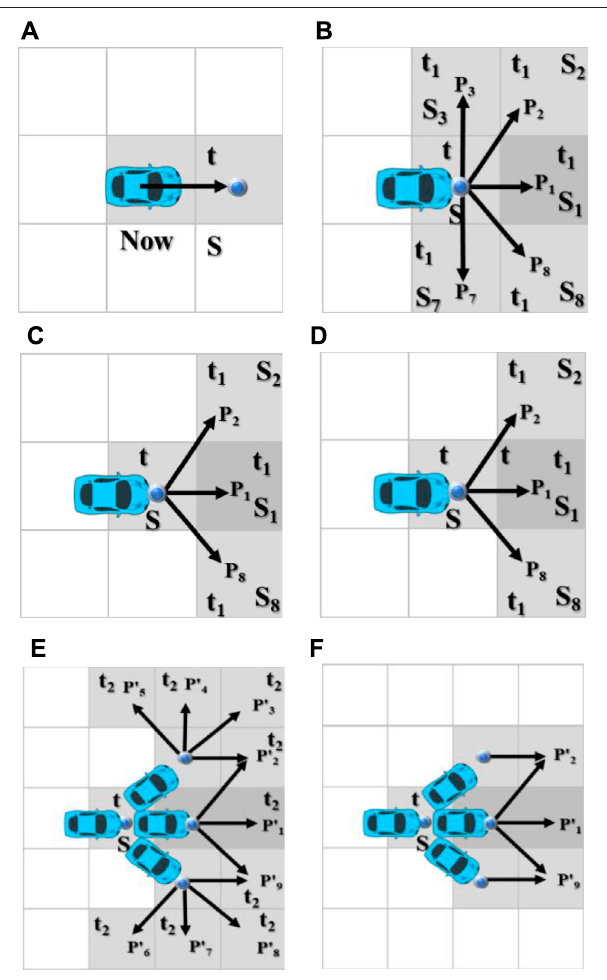
FIGURE 20 | Pruning and truncation of vehicle running probability. (A) t time entry diagram. (B) All feasible directions at t 1 . (C) Feasible direction